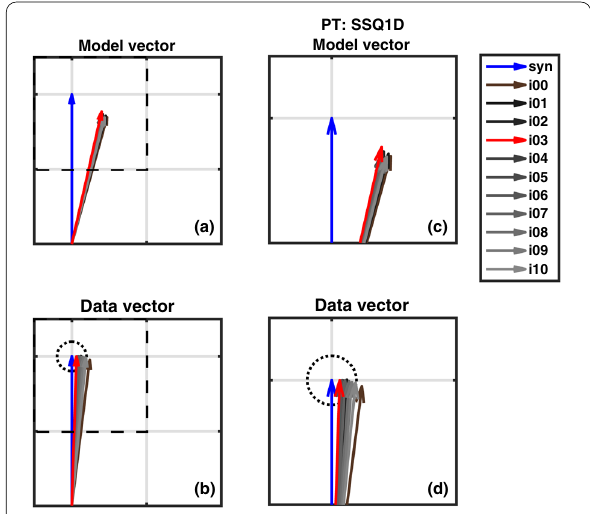
Fig. 15 2D representation of the a model and b data vectors derived from inverting synthetic PTATAN using SSQ1D as the initial model. They are enlarged in ( c ) and ( d ) to demonstrate how the model and data vectors evolve. The blue and brown arrows are the synthetic and initial model/data vectors, respectively. The red arrows are vectors from the iteration with the minimum dRMS. The gray grid shows the norm of 0.5 and the dashed circle represents the assumed observation error